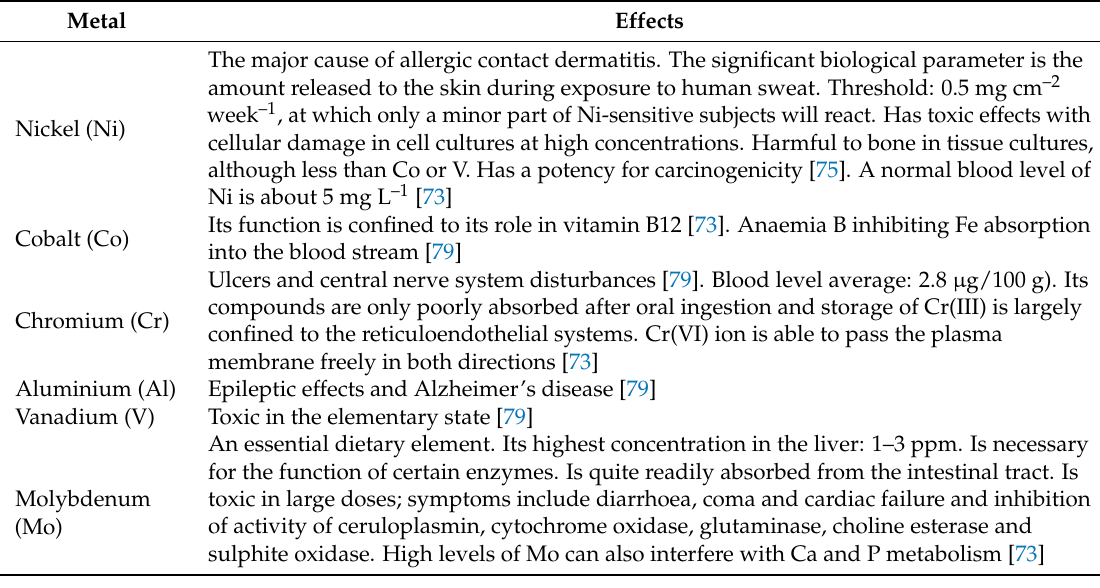
Figure 2. Two possible toxicity routes for metal ions released into body fluids due to corrosion and wear [42]. Reprinted with permission from Springer Nature. Table 3. The biological effects of certain metal ions that may be leached in vivo due to